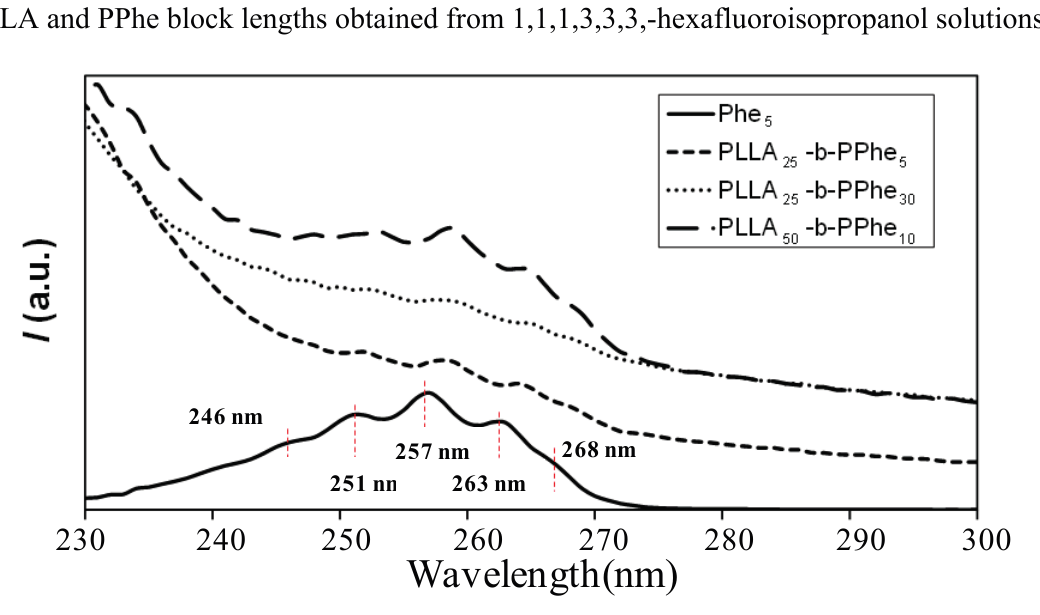
Figure 9. Powder X-Ray diffraction profiles of representative hybrid copolymers having blocks with different